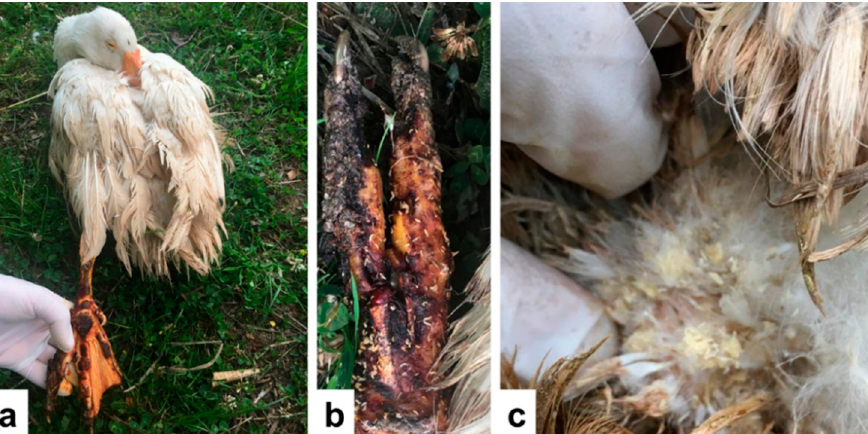
Figure 1. Traumatic myiasis by Lucilia sericata in a domestic goose. ( a ) Left leg and foot of the goose, showing trauma by rat bites. ( b ) Dorsal view of the foot, showing wound infested by dipteran larvae. ( c ) Plumage near the cloaca infested by eggs and larvae.